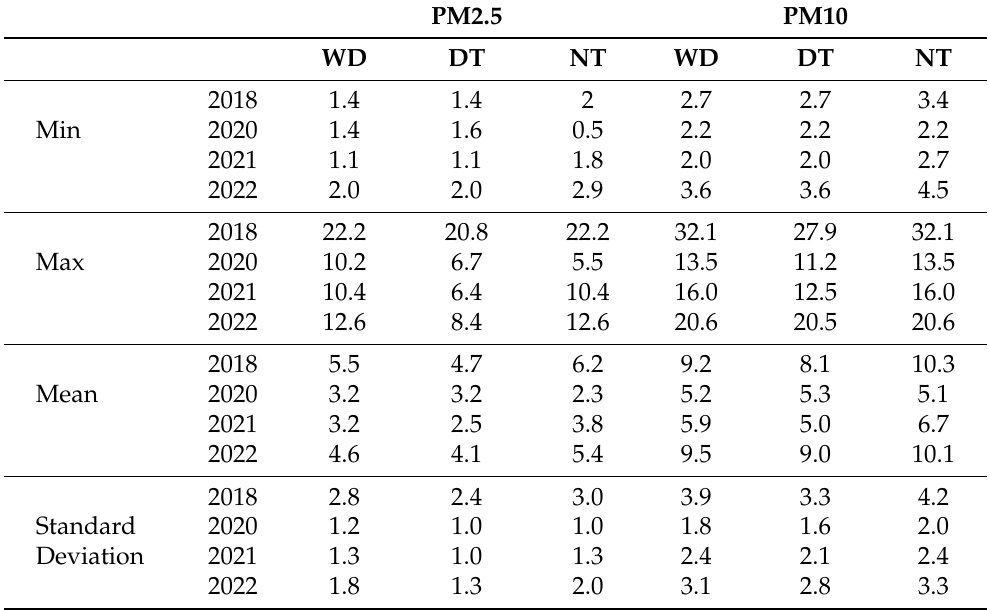
Table 4. Descriptive statistics for the concentration of PM2.5 and PM10 in the observed period during the whole day (WD), daytime (DT), and night-time (NT).